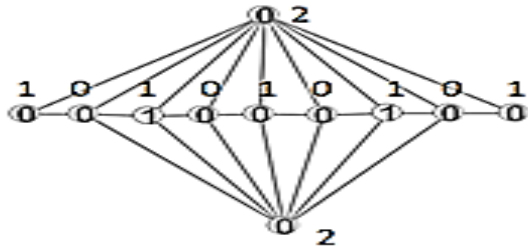
Figure 8 . Switching with modular coloring in Ws(9)